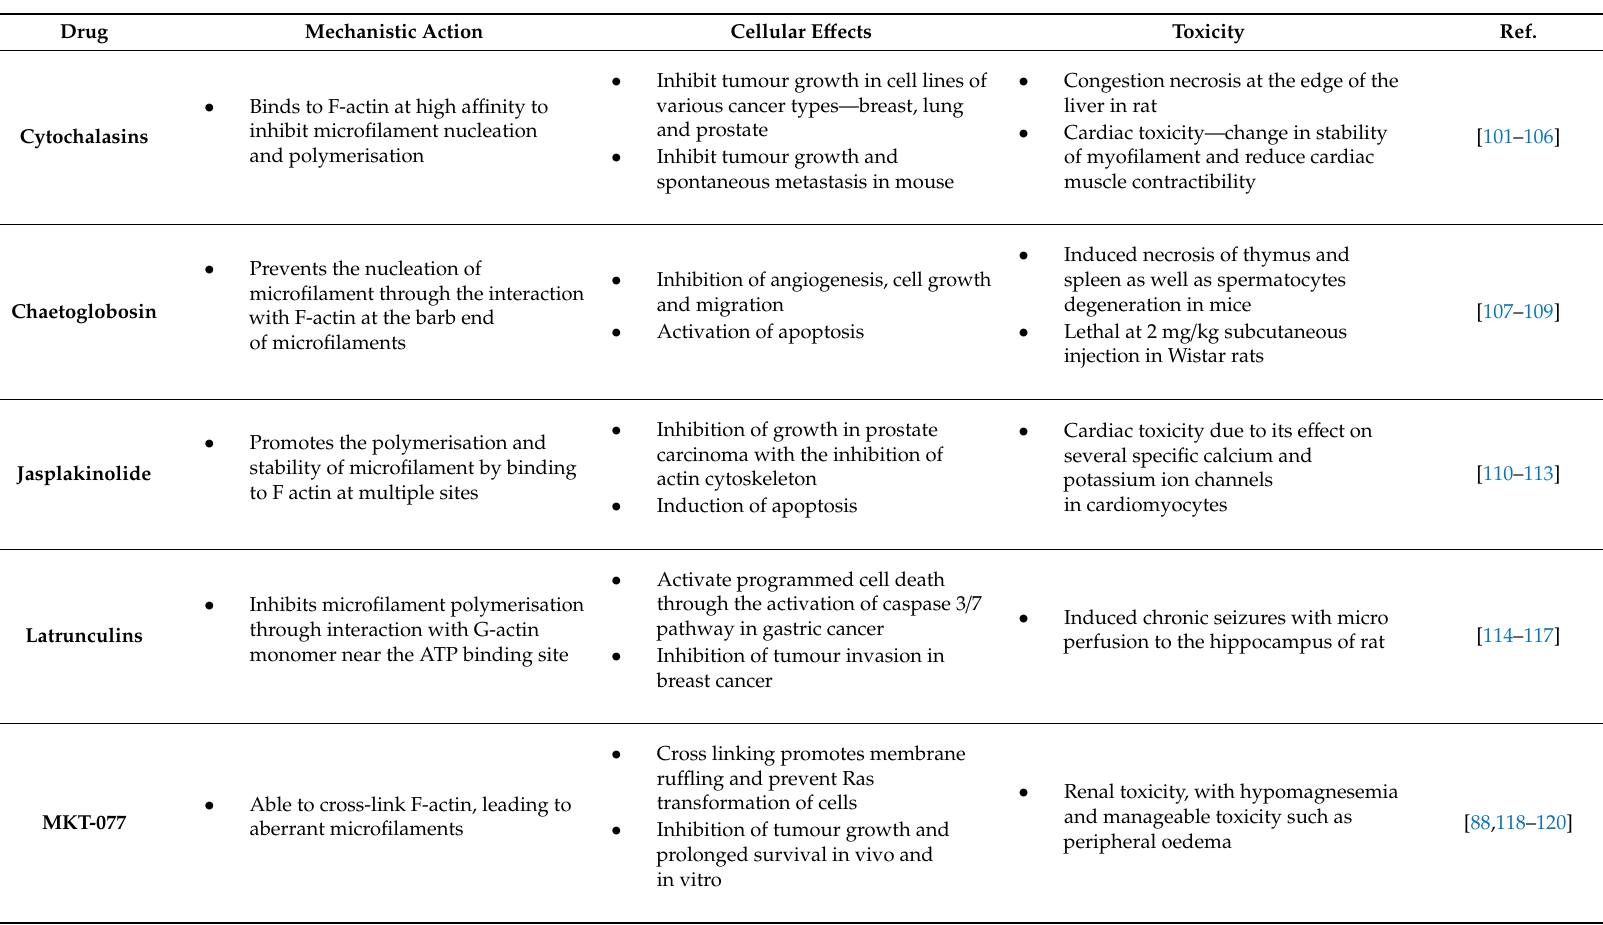
Table 2. Examples of actin microfilament drug actions and cellular e ff ects. Di ff erent actin microfilament drugs act to disrupt the actin dynamics and organisation in the cell. However, the importance of actin filaments in normal cell physiology also results in toxicity due to non-specificity (ATP, Adenosine